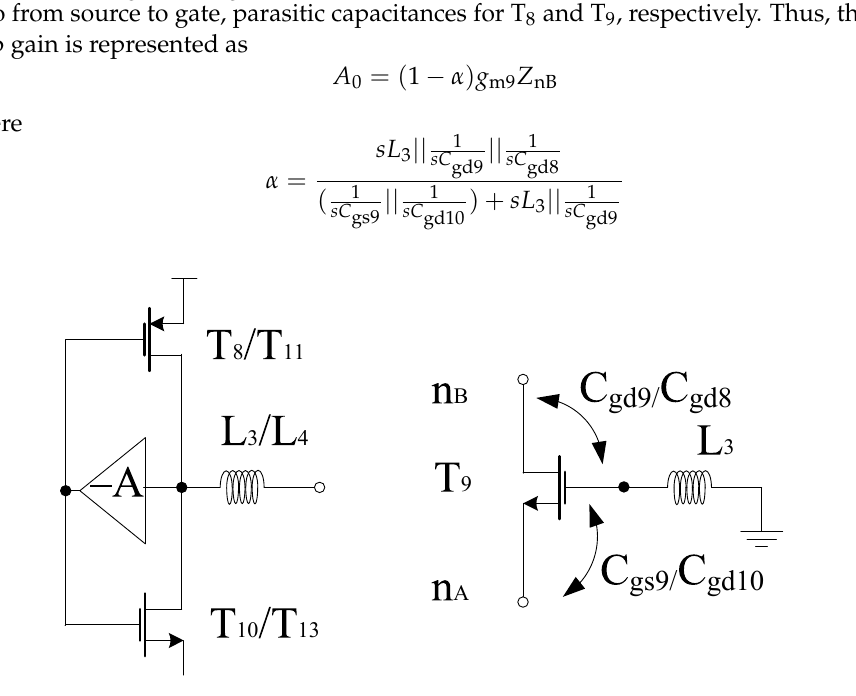
Figure 7. Gm stage